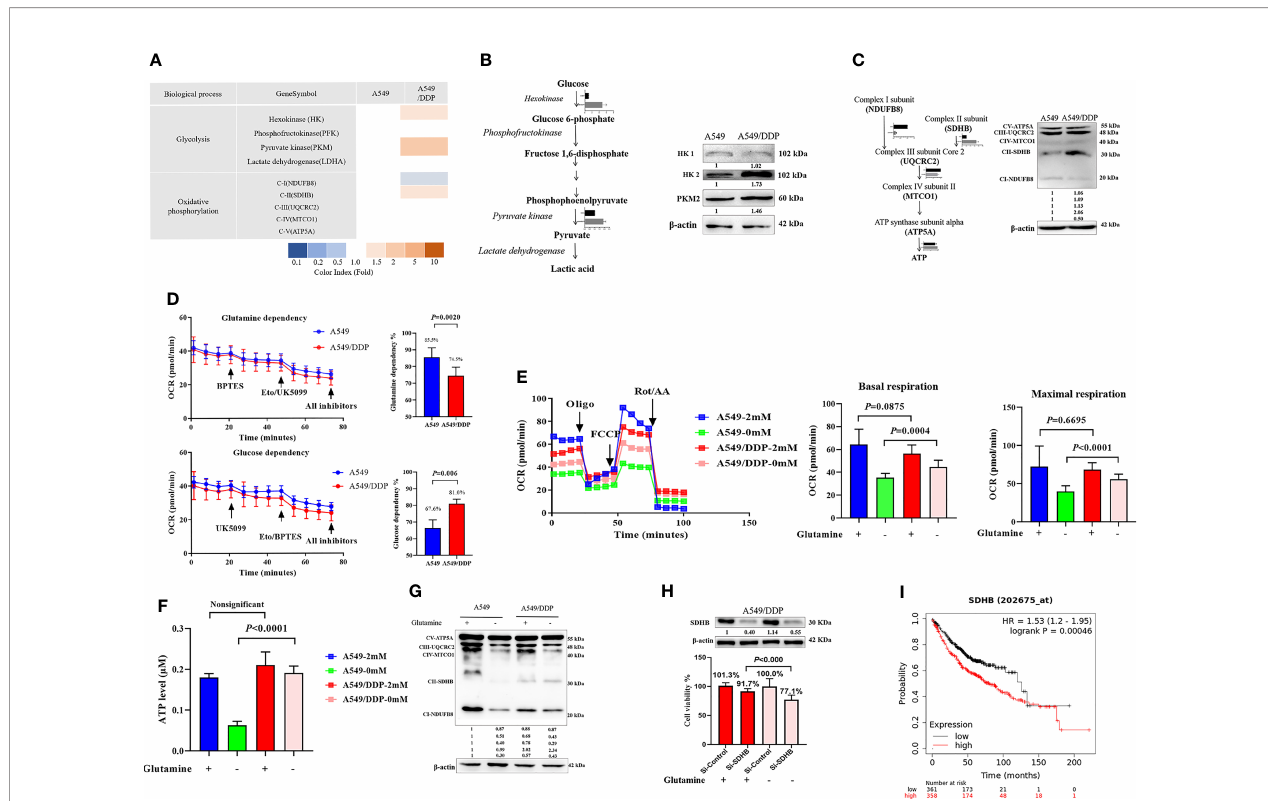
FIGURE 3 | Complex II-dependent OXPHOS drives the adaptive response during glutamine deprivation, and the SDHB subunit can be exploited as a vulnerability index of drug resistance in lung cancer. (A) Gene transcripts of glycolysis and respiration complexes generated by RNA-Seq analysis in A549 and A549/DDP cells cultured with 2 mM glutamine. (B, C) Blots of glycolysis and respiration complexes in A549 and A549/DDP cells cultured in basal medium containing glutamine (2 mM). b -actin served as loading control. (D) The glutamine dependency rate (measure of cell reliance on the glutamine oxidation pathway to maintain baseline respiration) was calculated using the following equation: Dependency% = [(BPTES OCR − Eto/UK5099 OCR)/(BPTES OCR − all inhibitors OCR)] × 100%. (E) Oxygen consumption was represented by basal and maximal respiration as measured by Seahorse XF assay in A549 and A549/DDP cells cultured with (+) or without ( − ) glutamine for 48 h. (F) ATP levels of A549 and A549/DDP cells cultured with (+) or without ( − ) glutamine for 48 h. (G) Blots of respiration complexes in A549 and A549/DDP cells cultured with (+) or without ( − ) glutamine for 48 h. b -actin served as loading control. (H) Blots of gene-silencing SDHB (succinate dehydrogenase [ubiquinone] iron-sulfur subunit, mitochondrial) in A549/ DDP cells and cultured with (+) or without ( − ) glutamine for 48 h using si-RNA. b -actin served as a loading control. Cell viability was monitored using a CCK-8 assay. Data were expressed as the mean ± SD, and the si-Control was set as 100% in glutamine-containing or glutamine-deprived medium of a representative experiment. (I) Kaplan – Meier analysis of overall survival of lung adenocarcinoma patients (n = 718) with respect to SDHB expression, demonstrating that higher expression is correlated with worse overall survival. All experiments were repeated at least three times, and results were expressed as mean ±